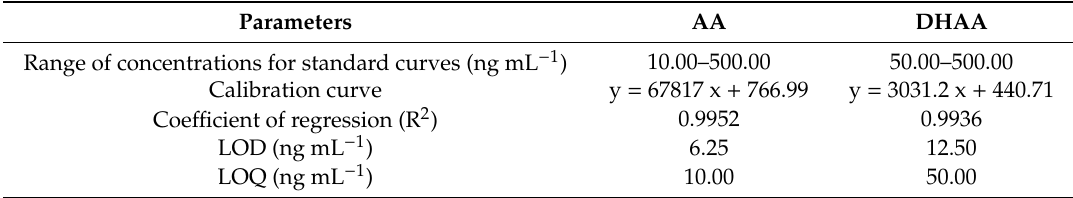
Table 2. Calibration data, linearity, limit of detection (LOD), and limit of quantification (LOQ) for ascorbic (AA) and dehydroascorbic (DHAA) acids.